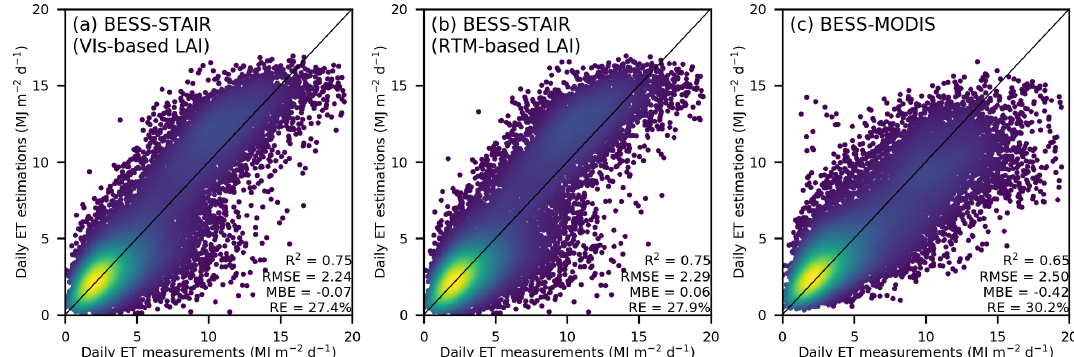
Figure 4. Density scatter plots between ET measurements and ET estimations. ET measurements are from eddy-covariance data collected at 12 flux towers. (a, b) BESS-STAIR ET with VI-based LAI and RTM-based LAI, respectively. (c) 500m BESS ET with MODIS